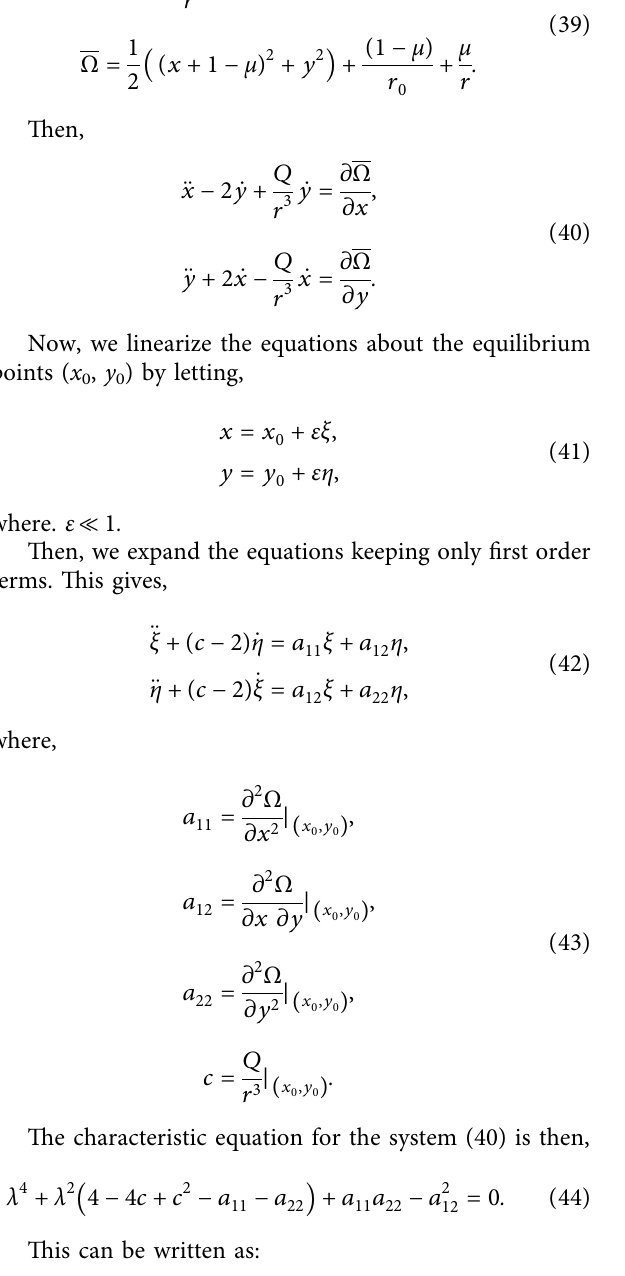
x � − ( 1/2 ) against the 4 x-coordinate